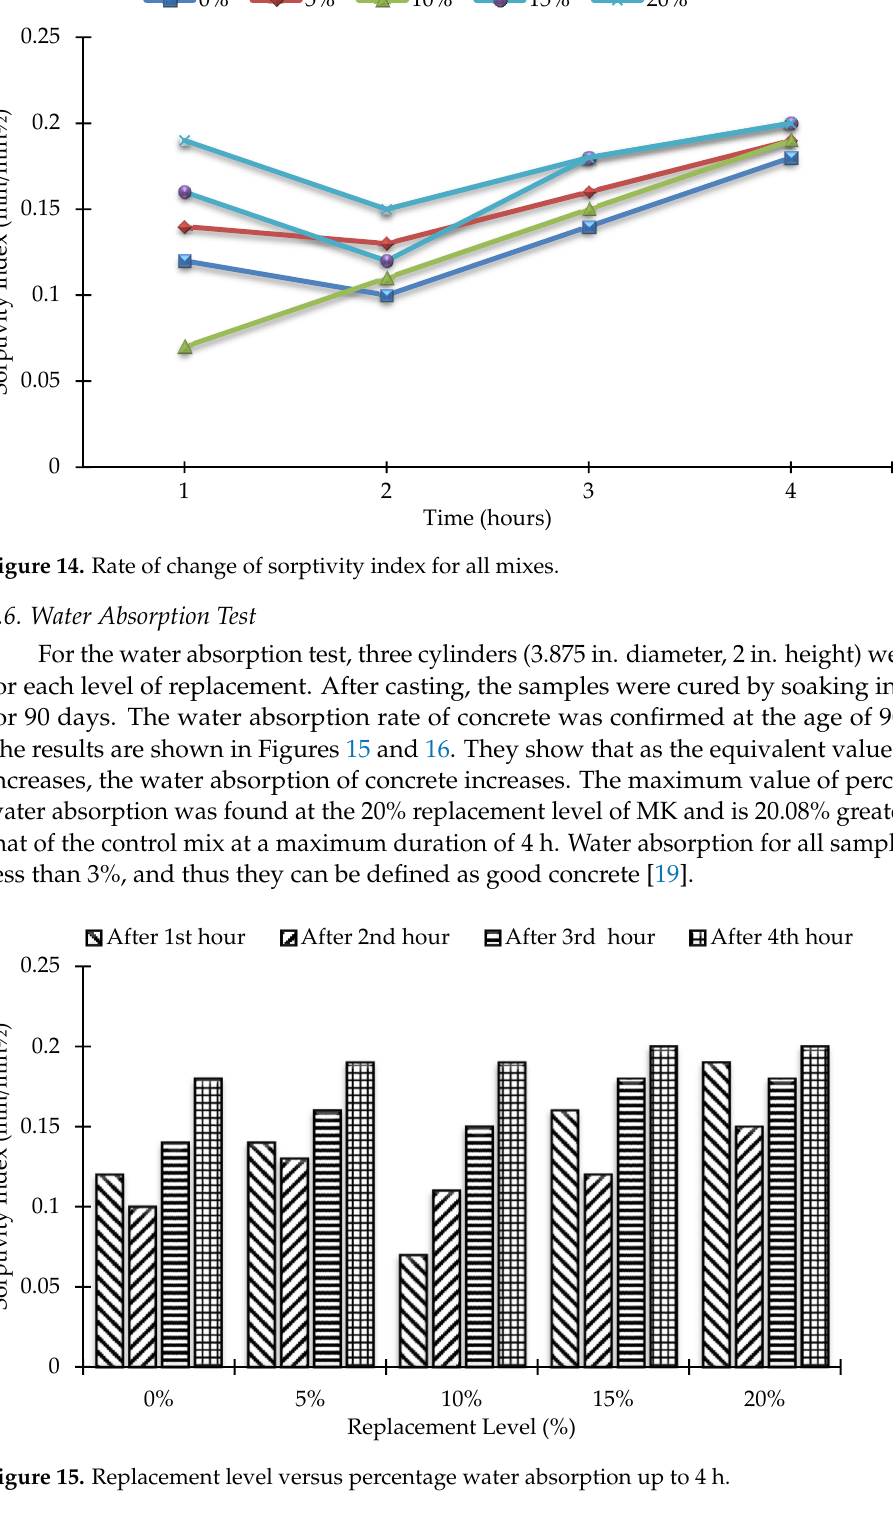
Figure 13. Replacement level versus sorptivity index up to 4 h.